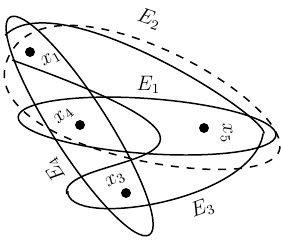
Figure 11. A single level of the hypergraph